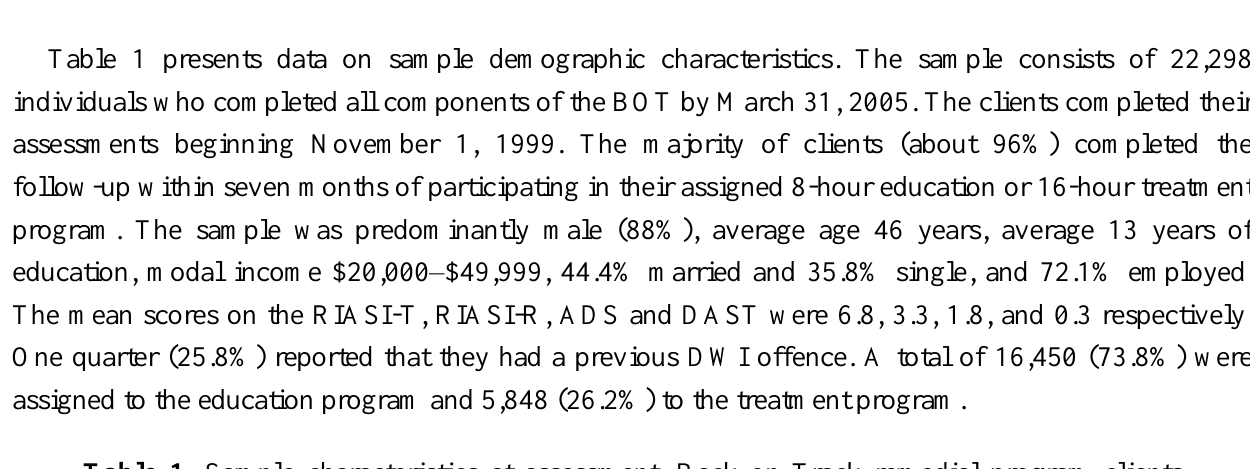
Table 1. Sample characteristics at assessment. Back on Track remedial program clients (N =